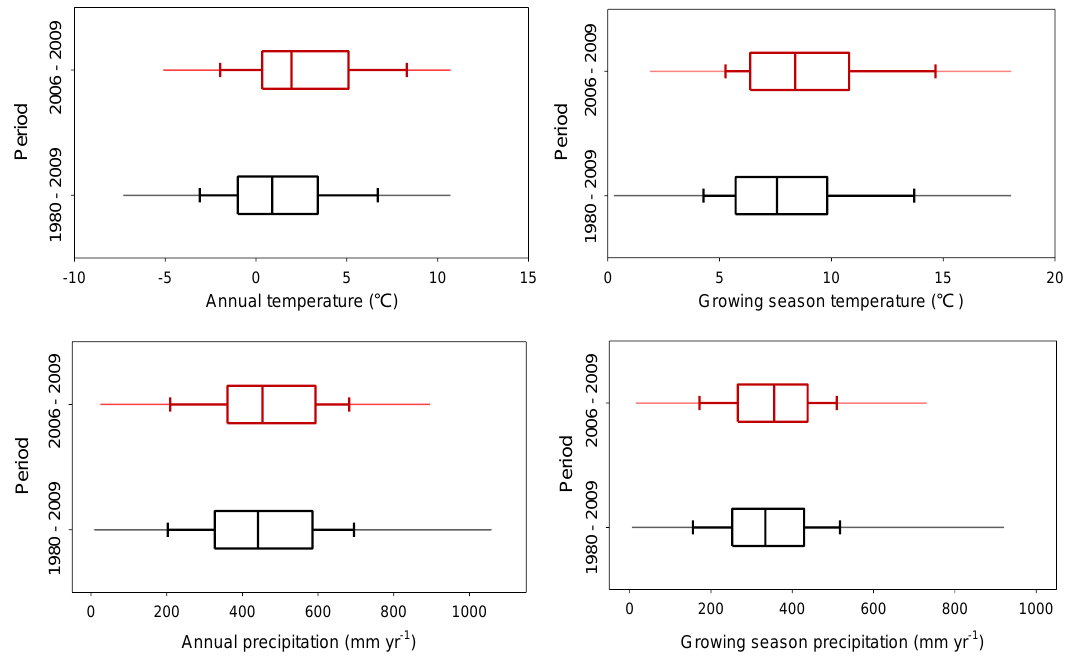
Fig. 2. Box plots of annual temperature, annual precipitation, growing season temperature and growing season precipitation collected from 49 meteorological stations during the current period of study (2006–2009) and 30 years (1980–2009) in the past. The box plots show the median, quartiles and 10th and 90th percentiles of the climatic